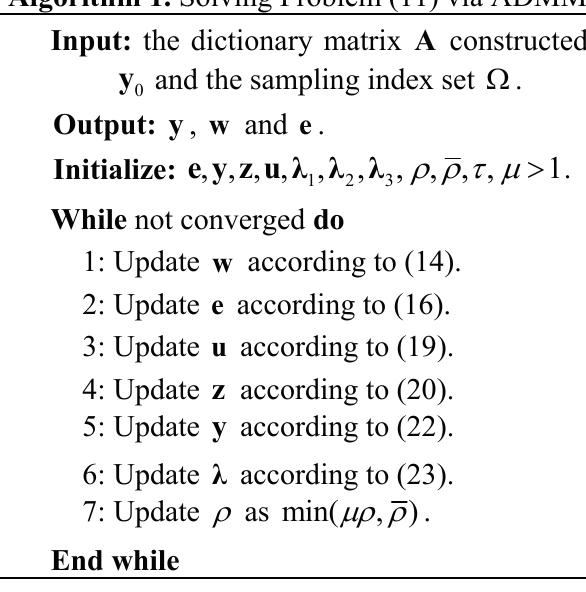
Algorithm 1. Solving Problem (11) via